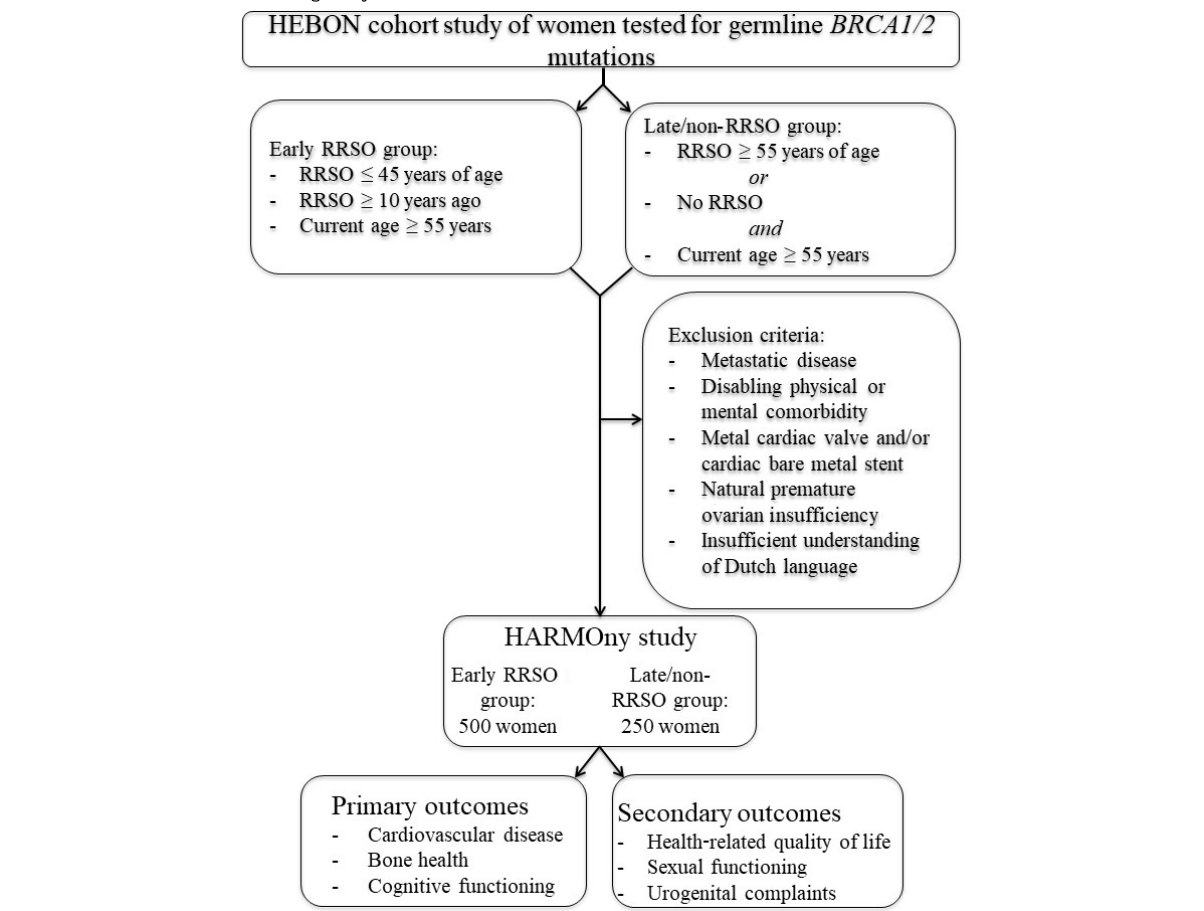
Figure 2. Schematic overview of the eligibility